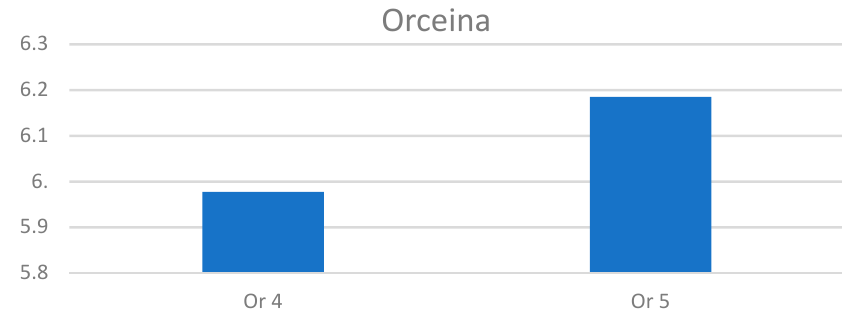
Figure 23. The comparison of specimens stained with orcein before and after the treatment revealed 61.8% rise in elastin concentration.